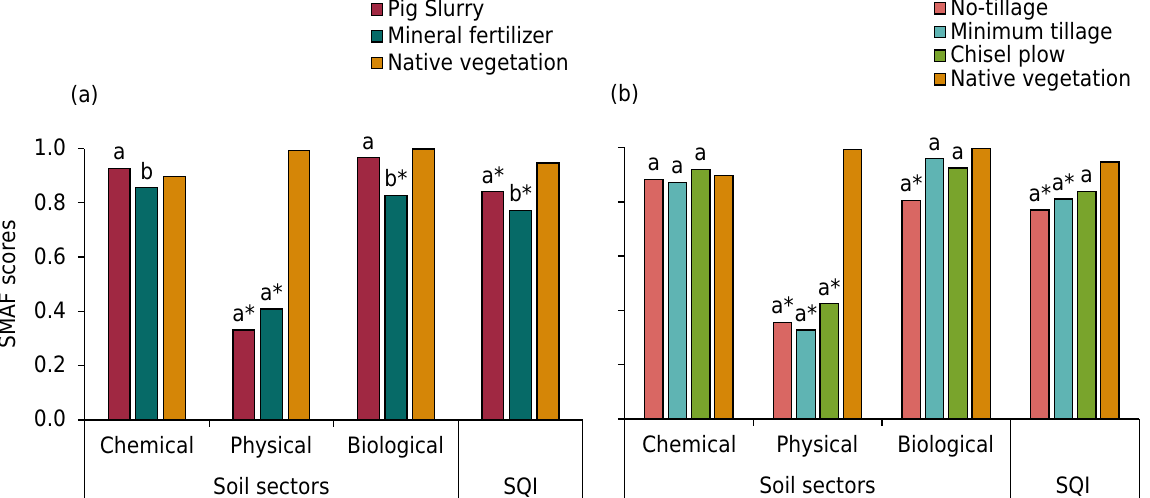
Figure 4. Soil sectors (chemical, physical, and biological) and overall Soil Quality Index (SQI) for the 0.00-0.10 m layer under pig slurry and mineral fertilizer treatments (a) and no-tillage, minimum tillage, and chisel plow treatments (b). All treatments were compared with native vegetation. Mean scores within each sector and SQI followed by the same letter do not differ among themselves according to Tukey’s test (p<0.1). Mean scores followed by * statistically differ from native vegetation according to Dunnett’s test